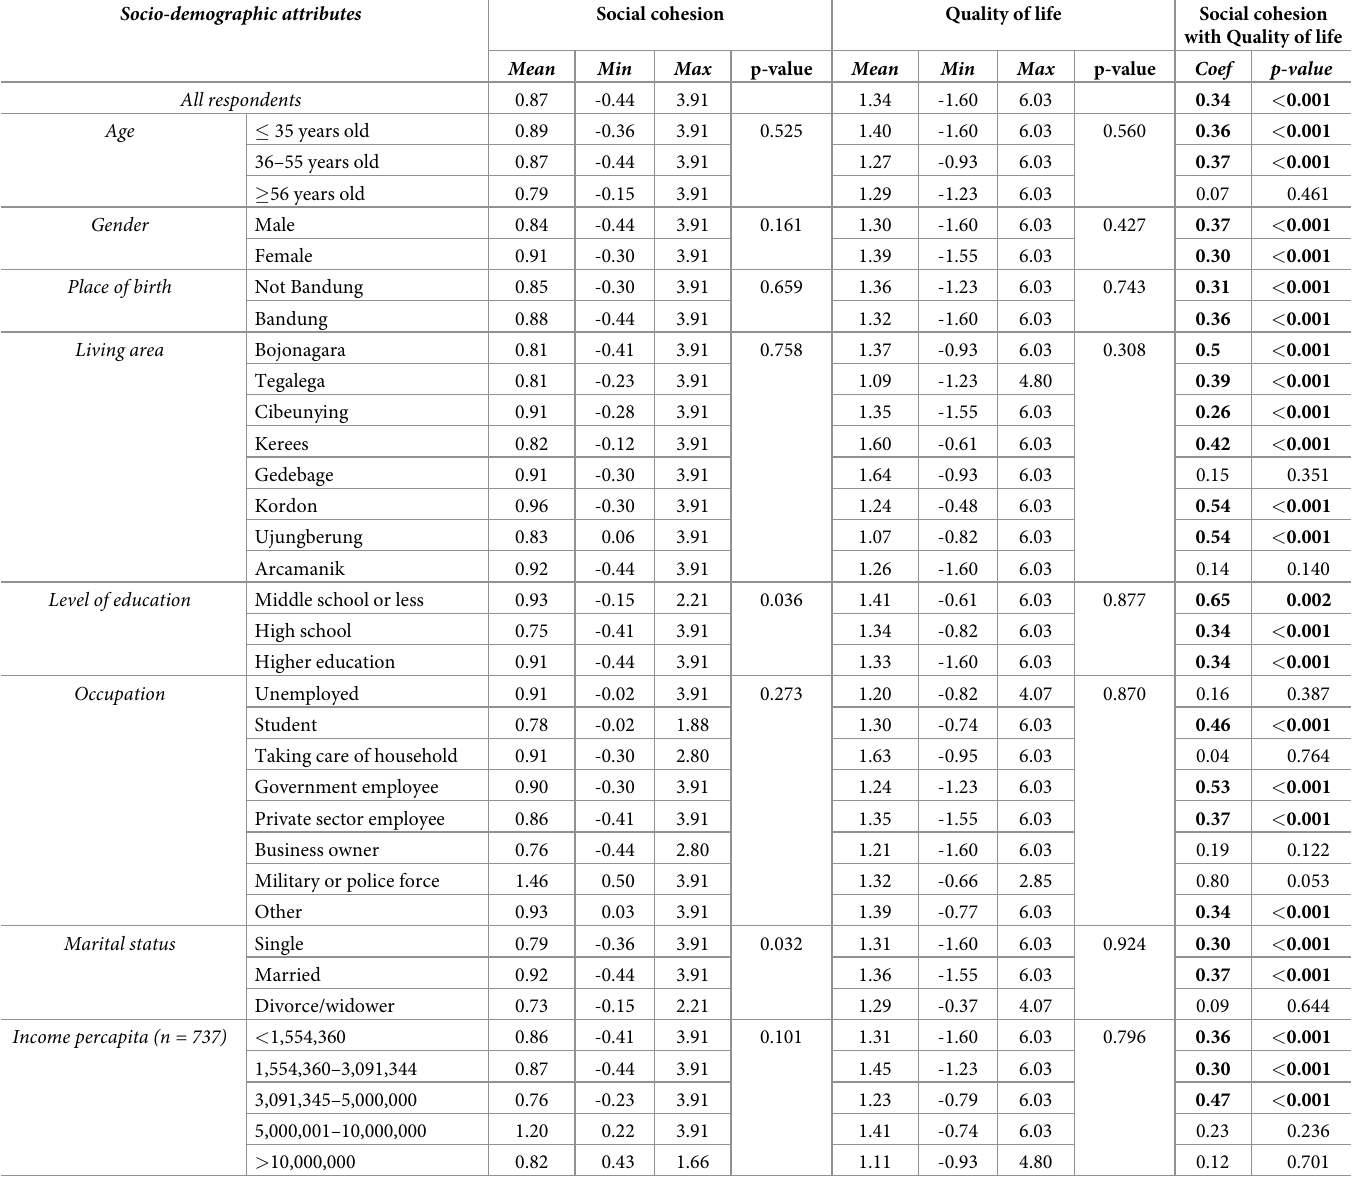
Table 2. Social cohesion and quality of life analysis based on the sociodemographic attributes. Socio-demographic